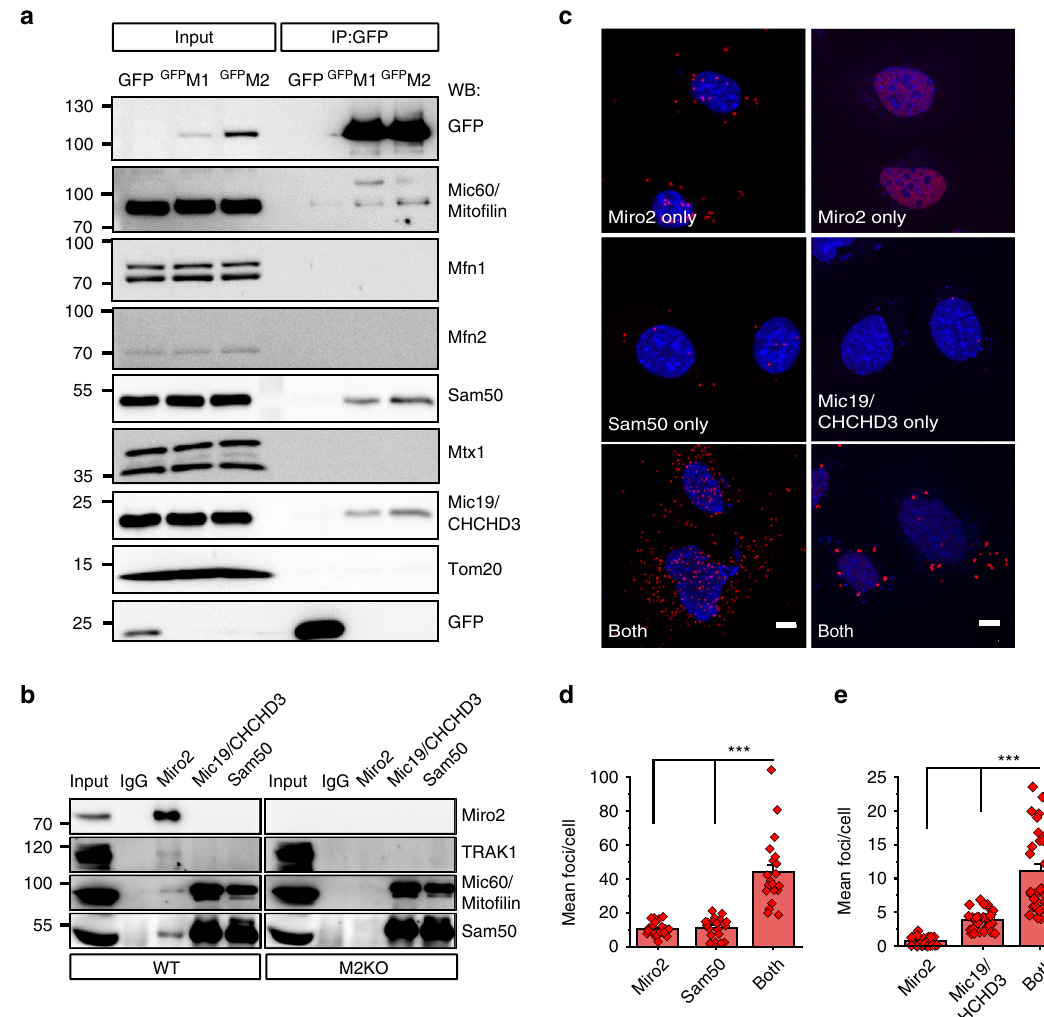
Fig. 3 Miro proteins are a component of the MICOS complex. a Miro proteins interact with MICOS complex proteins. Western blot analysis of GFP Miro protein complexes from HeLa cells were analyzed in SDS-PAGE for several MICOS components. b Co-immunoprecipitation of Miro2 with endogenous MICOS complex proteins. Immunoprecipitation was performed from WT and Miro2 KO brains, and western blot was performed with different antibodies against MICOS complex proteins. Approximately 2% of total cell lysate used for immunoprecipitation was loaded for inputs. c Proximity ligation assay (PLA) between Miro2 and OMM protein Sam50 (left panel) as well as PLA between Miro2 and the MICOS-speci fi c protein Mic19/CHCHD3 (right panel). The nucleus is shown in blue (DAPI), and PLA assay products are shown in red (scale bar: 5 μ m). d , e Quanti fi cation of the experiments shown in ( c ); (for ( d ) n = 23 images with only Miro2 antibody, 20 images for only Sam50 antibody, and 20 images with both antibodies and for ( e ) n = 27 images with only Miro2 antibody, 29 images for only Mic19/CHCHD3 antibody and 44 images with both antibodies, both from three independent experiments; One-way ANOVA, Bonferroni post hoc). Error bars represent ± SEM. Signi fi cance: *** p <